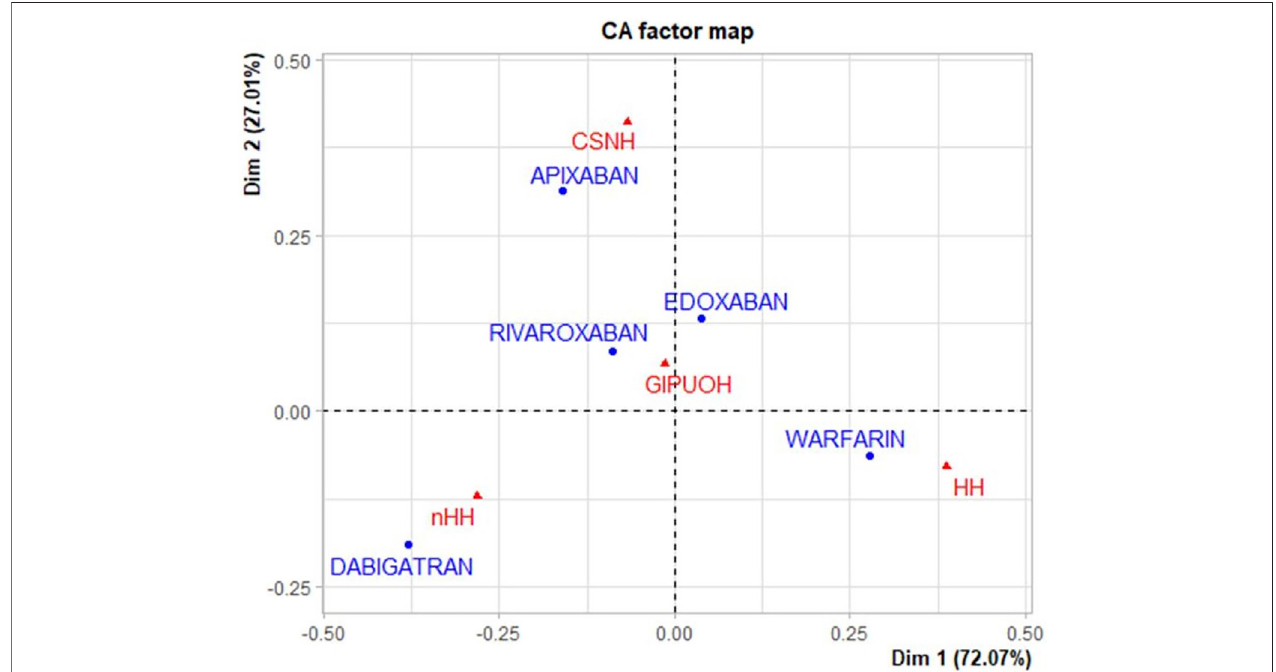
FIGURE 4 | Correspondence analysis biplot of AEs and oral